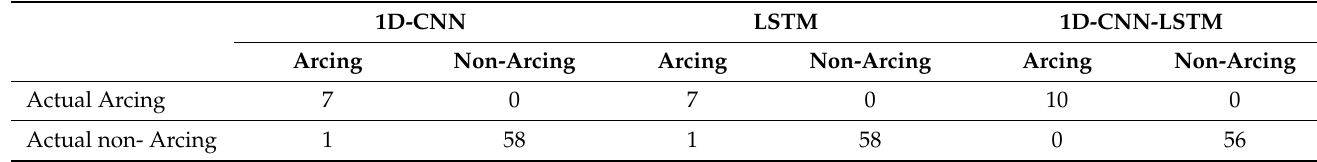
Table 7. Testing Phase Output Matrix: Time Domain Arcing Fault